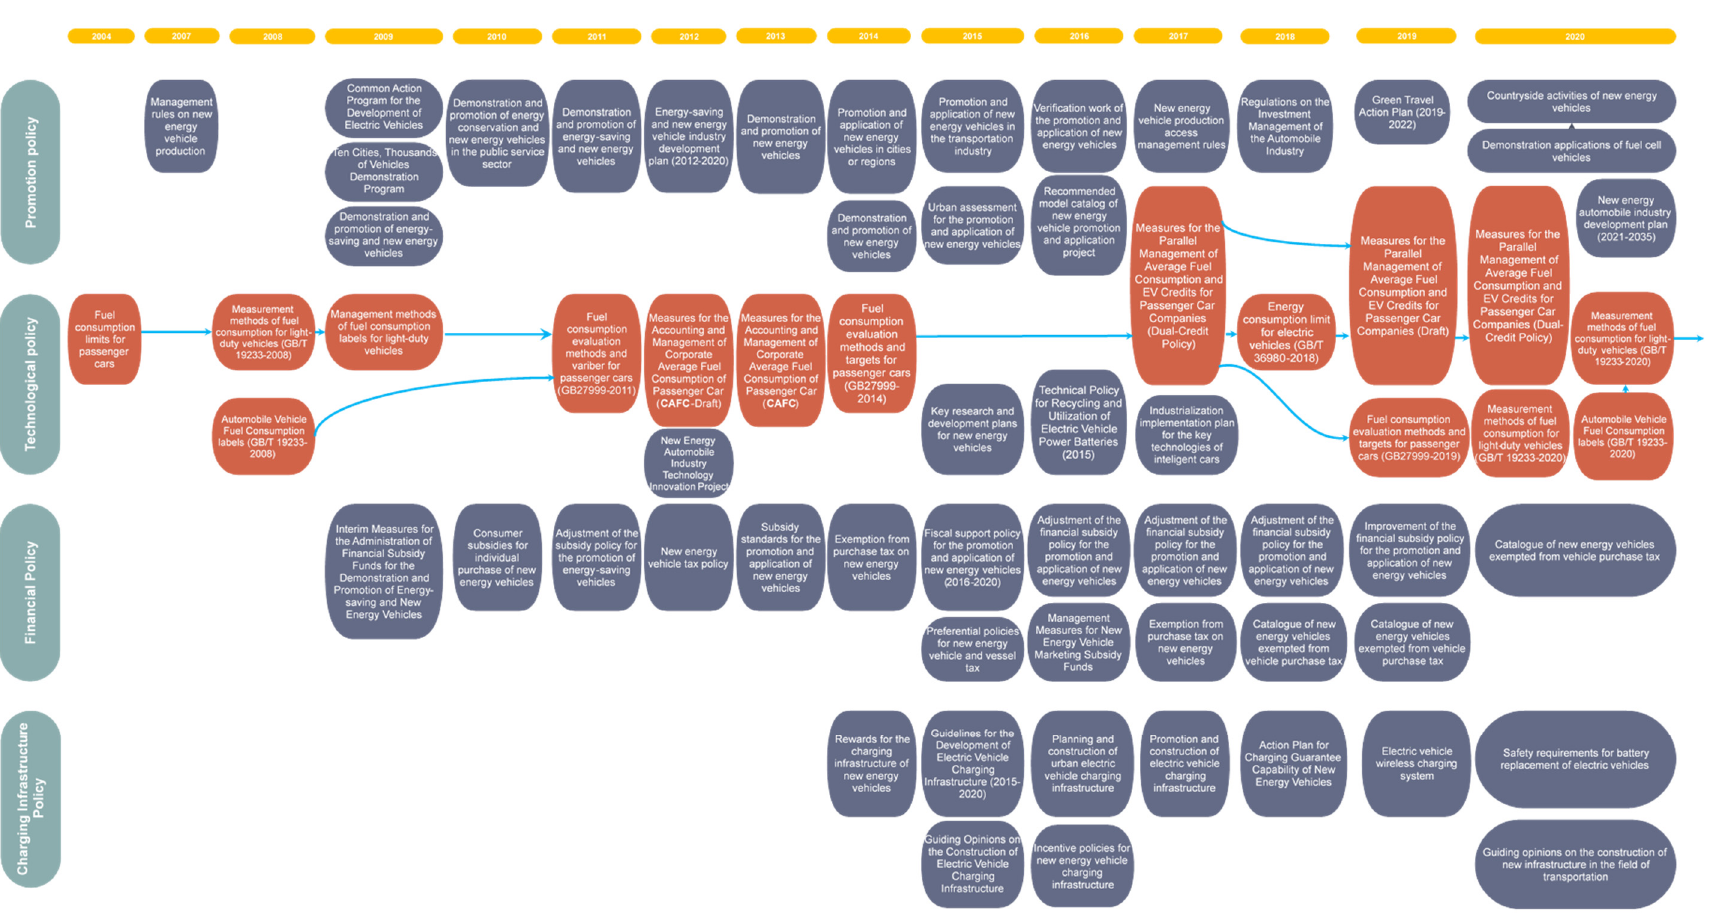
Figure 2. The dual-credit policy in Chinese new energy vehicle industry policies.